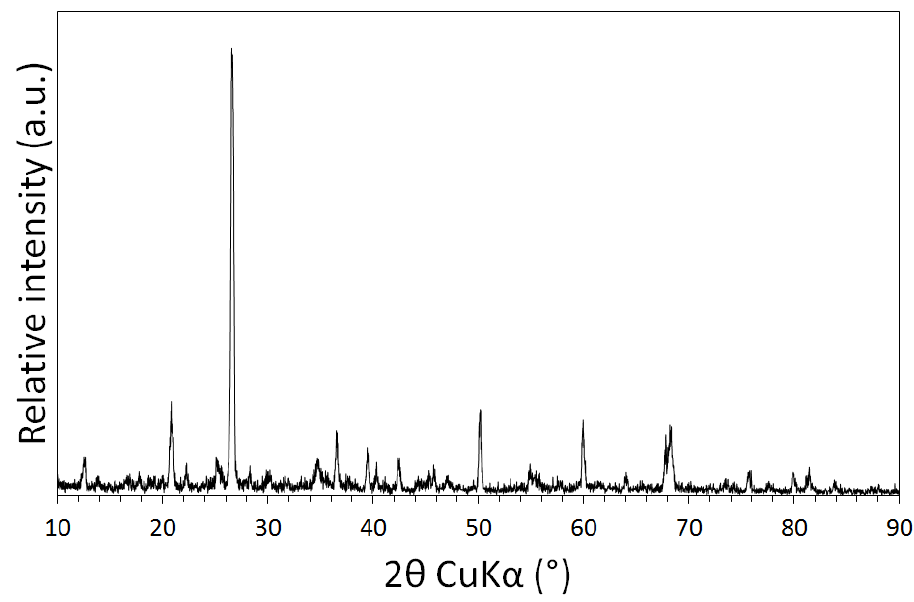
Figure 1. XRD spectra of the composite mine tailings sample.